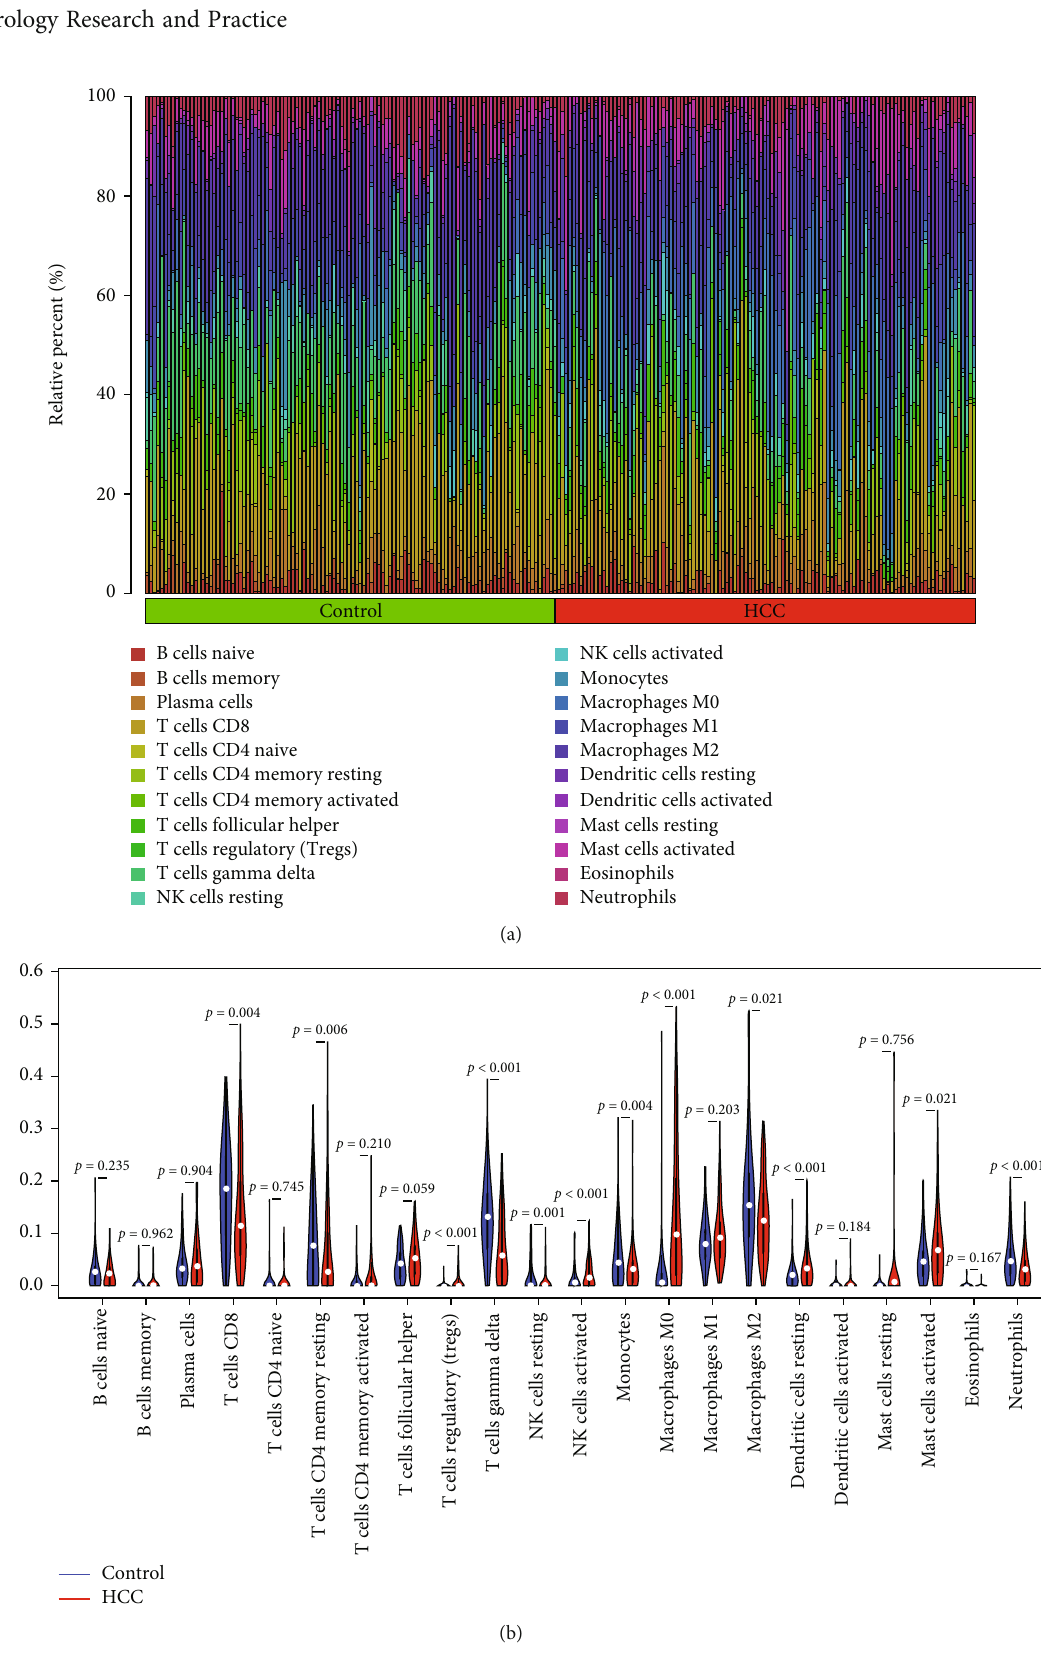
Figure 7: The view of immune in fi ltration between HCC and controls. (a) Violin diagram of the proportion of 20 types of immune cells between HCC and normal controls. (b) The di ff erence of immune in fi ltration between HCC and normal